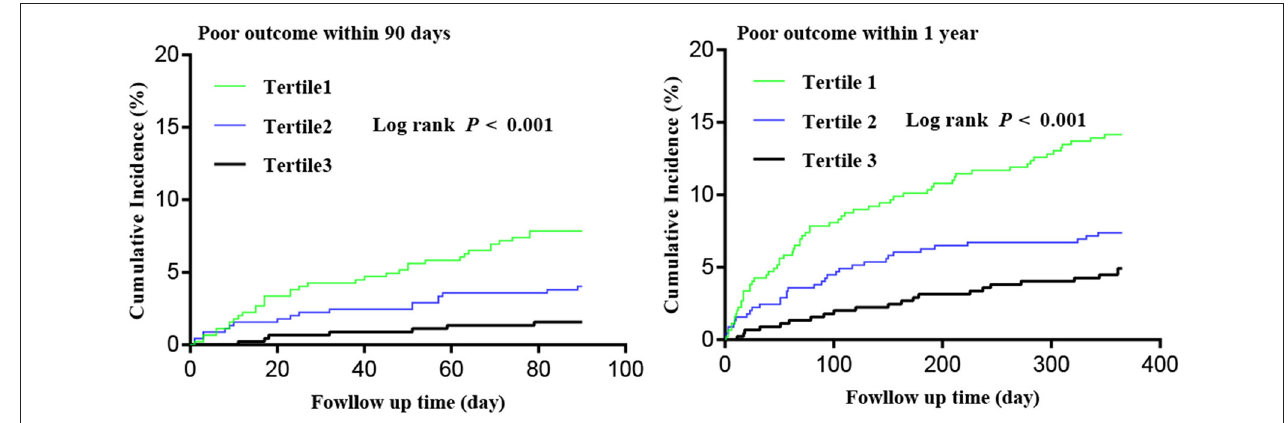
FIGURE 2 | Kaplan–Meier curves of cumulative incidence (%) of poor outcome by tertiles of hemoglobin, albumin, lymphocyte, and platelet (HALP) score at 90-day and 1-year follow-up.